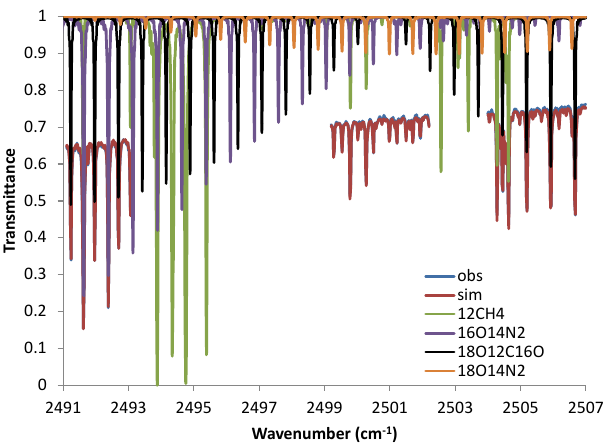
Figure 3b. Same as Fig. 3a, except for TH = 23.72km, at which tangent height, two N 2 CIA microwindows are